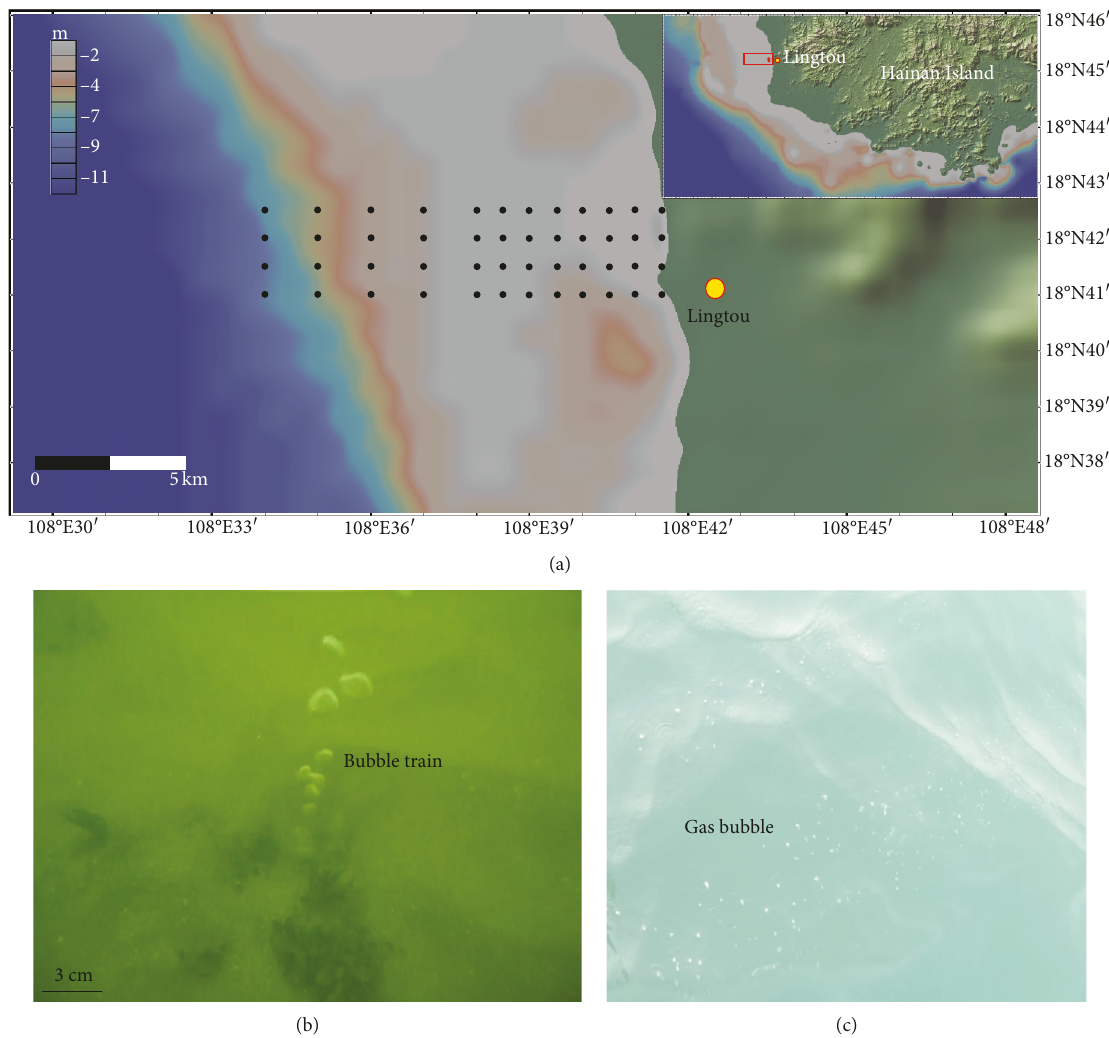
Figure 1: (a) Bathymetric map of the hydrocarbon seep area near Lingtou Promontory. The red dots show the distribution of the nearshore hydrocarbon seeps, and the black dots are the seawater sample grid. (b) Photograph of rising irregular gas bubbles from a seep site. (c) Gas bubbles at the sea